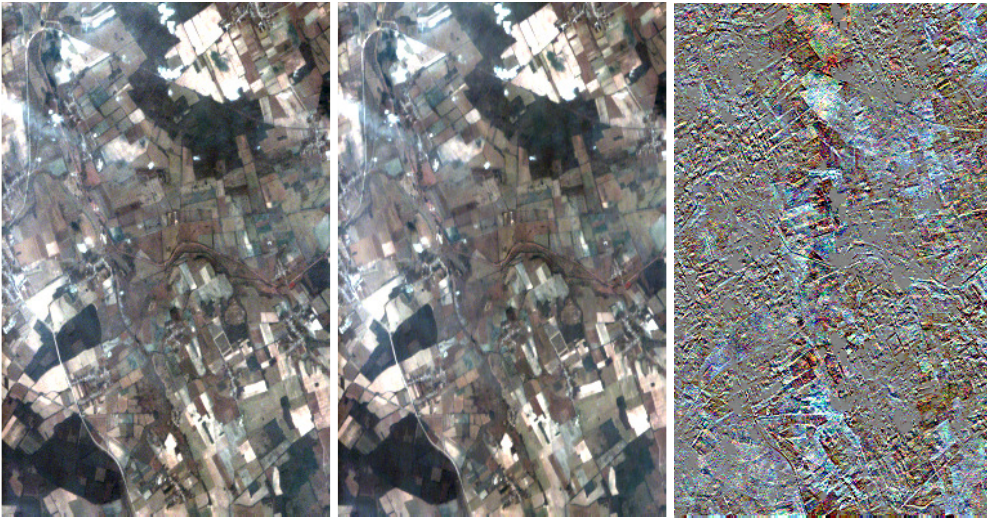
Figure 2. Original (left) and NLM denoised (middlke) RGB Ajka image. Difference of the two images (estimated noise) is shown on the right composing the differences of the same RGB